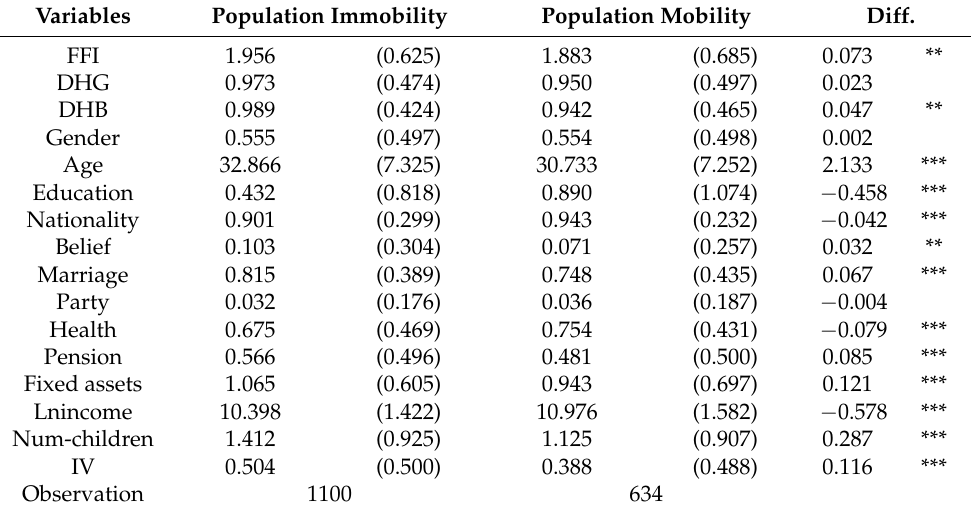
Table 3. The mean differences in the variables between farmers who choose to move and those who do